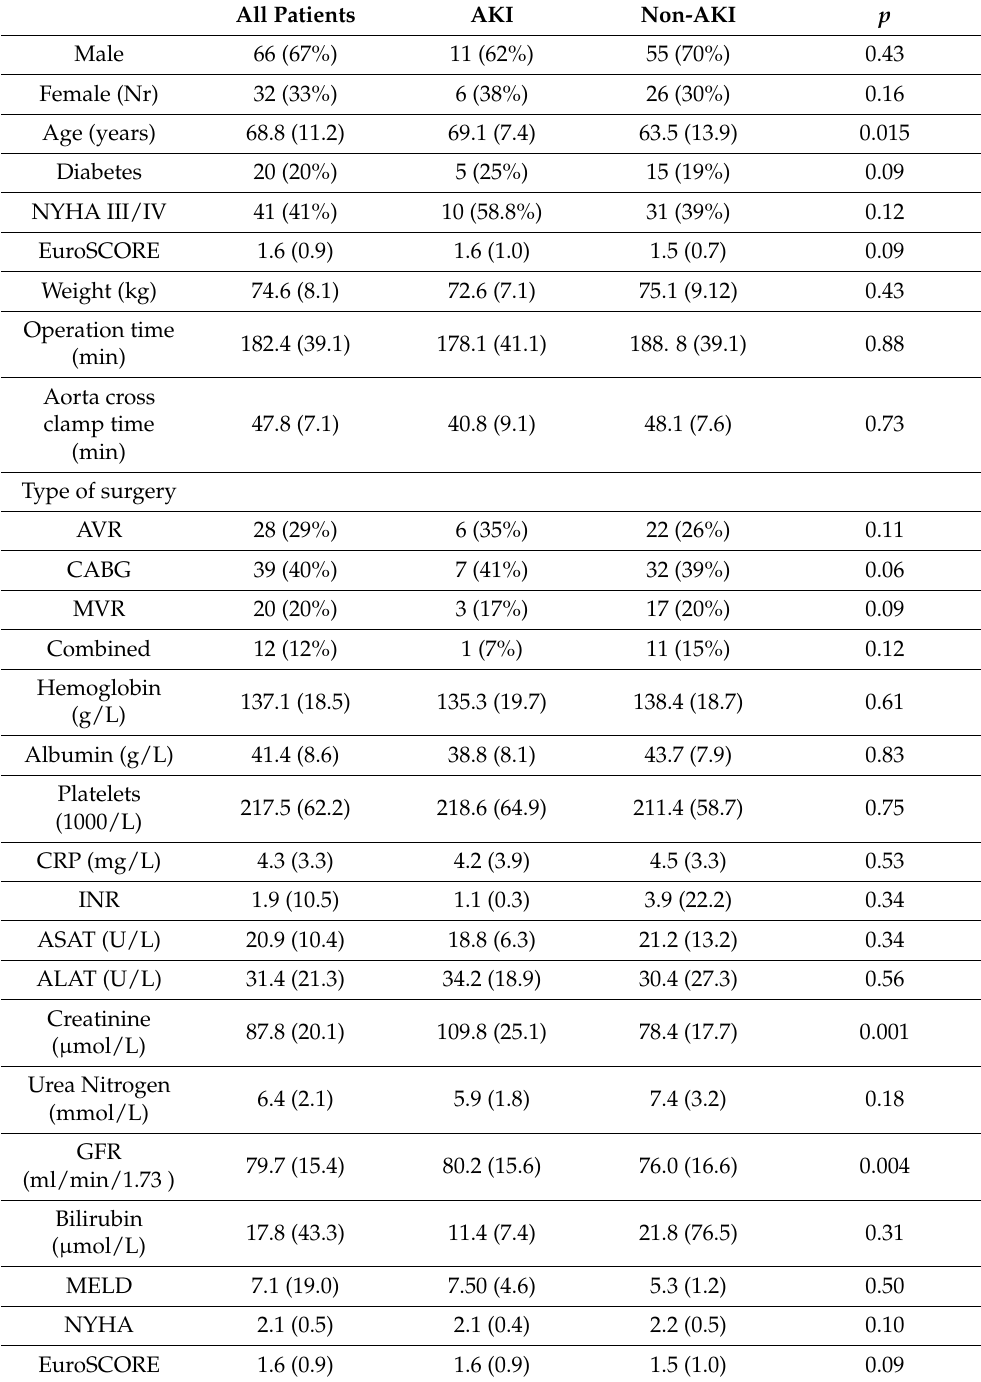
Table 1. Demographic and clinical data of the population and the AKI and non-AKI